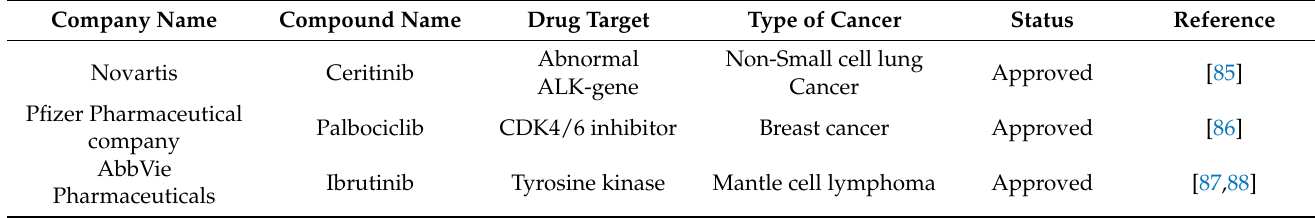
Figure 38. Pyrimidine based FDA approved drugs. Table 28. FDA approved pyrimidine based hybrids.